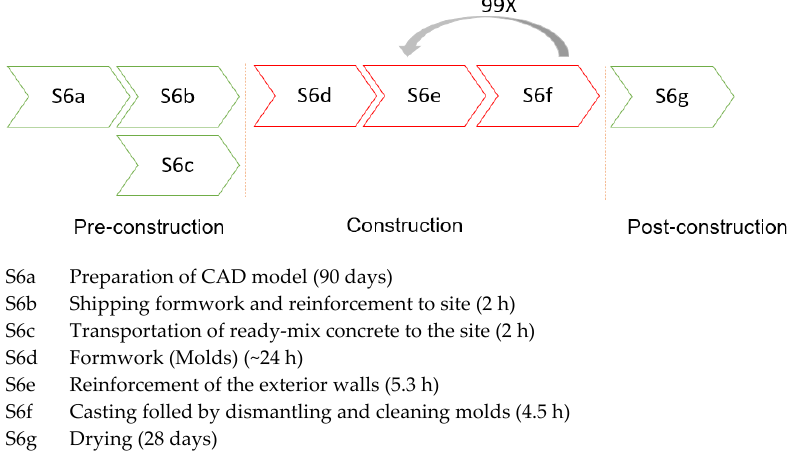
Figure 8. The process map of Scenario 6.